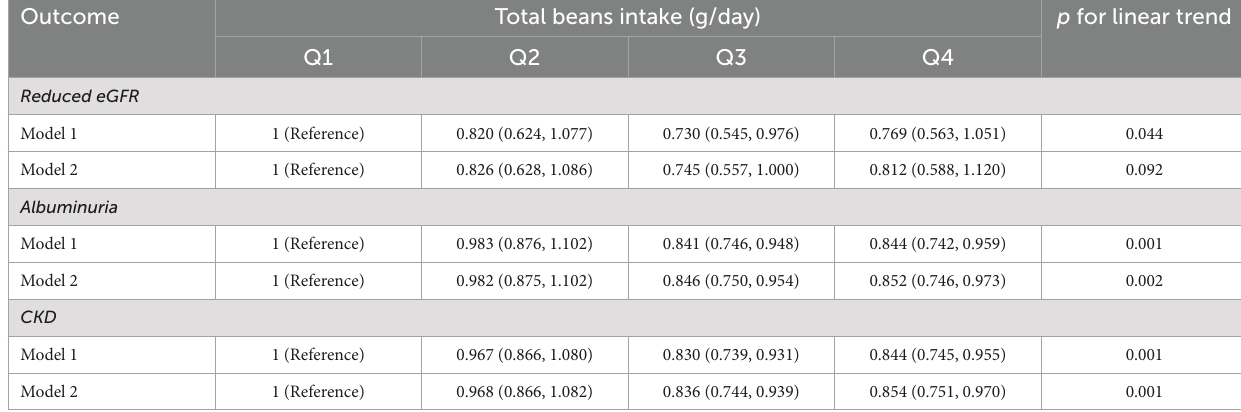
TABLE 3 Multivariable-adjusted OR and 95% CI for reduced eGFR, albuminuria and CKD according to quartiles of total beans intake.